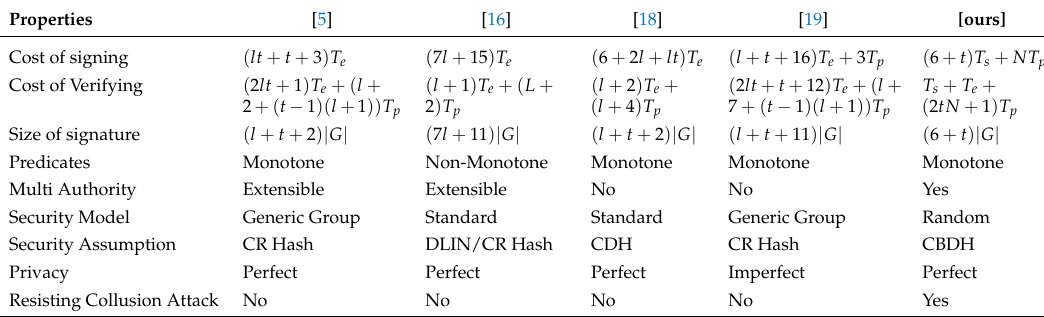
Table 1. Comparison of attribute-based signature